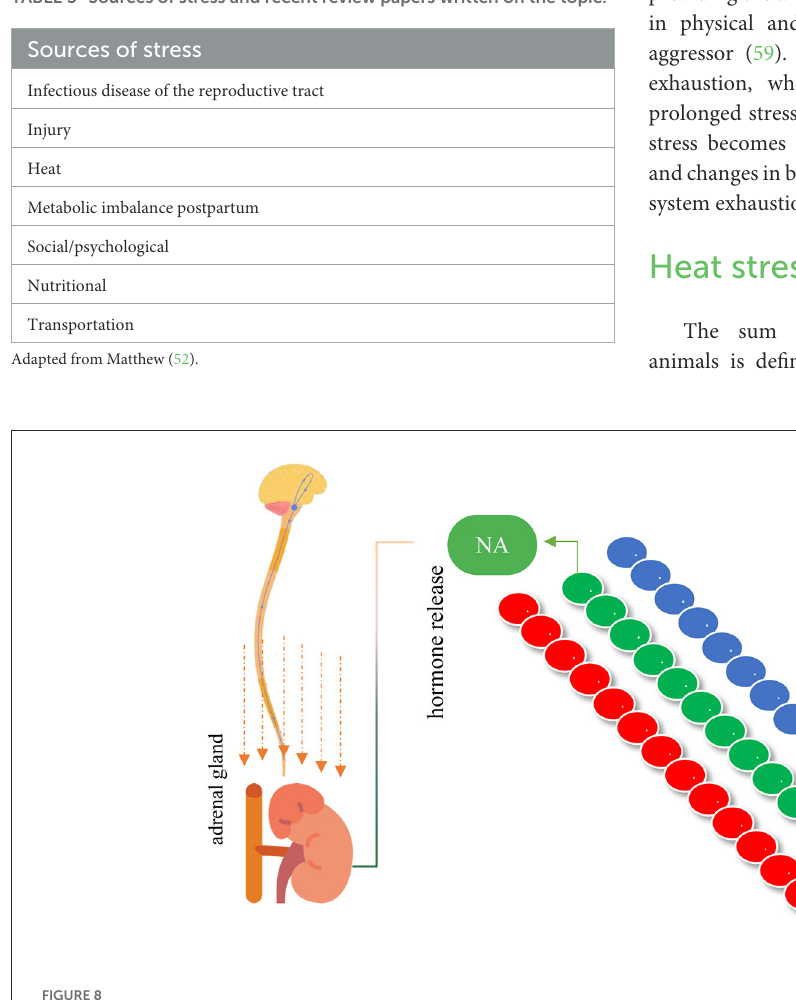
TABLE 3 Sources of stress and recent review papers written on the topic.